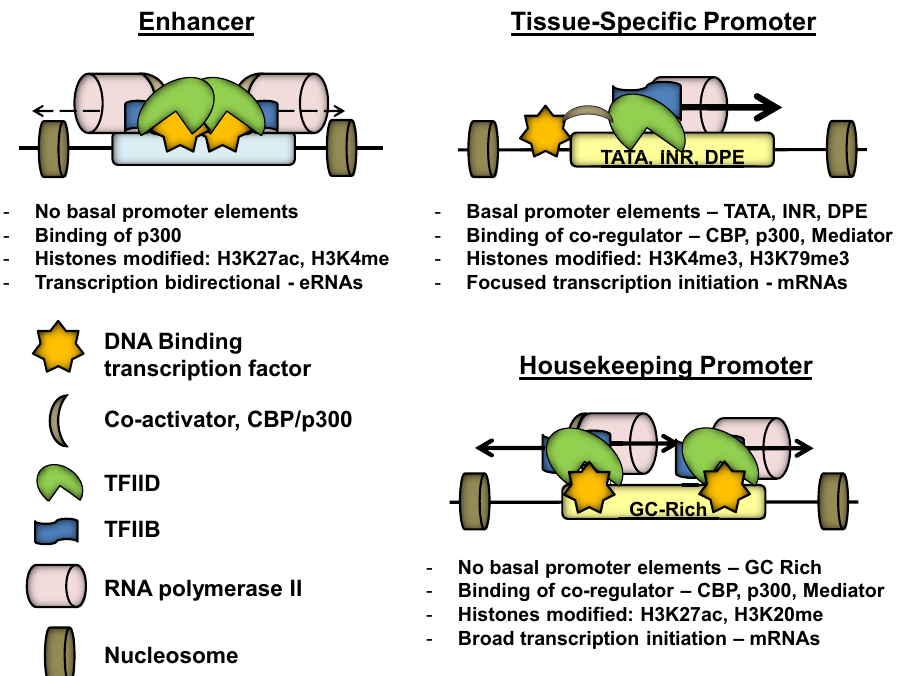
Figure 1. Comparison of the structure and features of enhancer, as well as housekeeping and tissue-specific promoters. Promoters and enhancers are characterized by specific chromatin signatures and recruitment of transcription factors as indicated by the symbols, which are described in the lower left